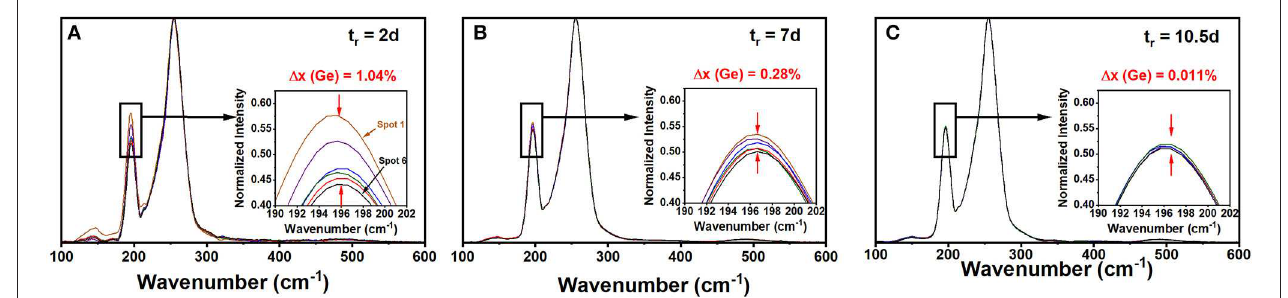
FIGURE 1 | FT-Raman spectra of a Ge 9 As 9 Se 82 glass composition profiled after being alloyed at 950 ◦ C in (A) 2d, in (B) 7d, and in (C) 10.5 d. The variance <1 × > Ge in Ge concentration “x” across the batch decreased from 1.04(5) to 0.28(5) to < 0.05% upon progressive alloying as revealed by the spread in the normalized scattering strength of the Corner-Sharing mode near 200 cm − 1 in insets. The Omnic software normalizes each spectrum to the most intense peak near